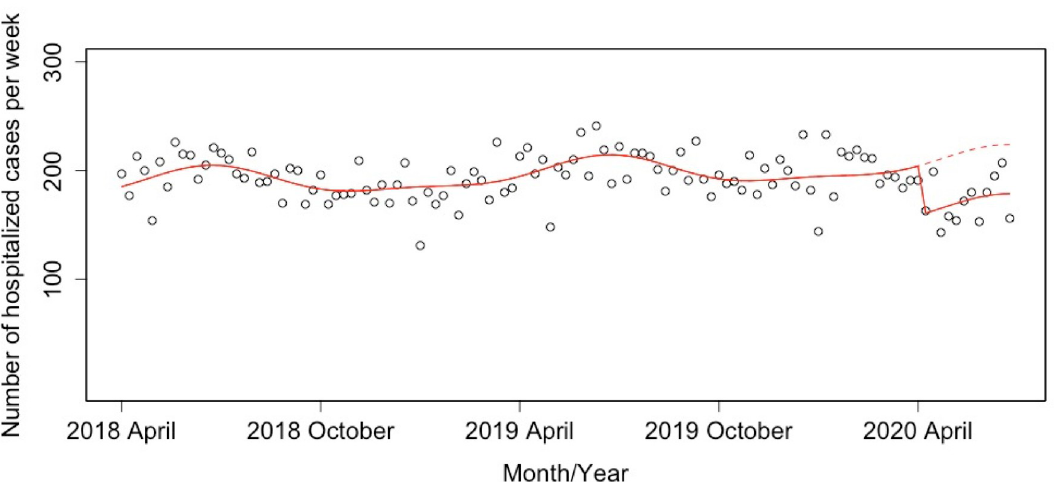
Fig 2. Result of the interrupted time series analysis for the weekly number of independent group inpatients with ischemic stroke between April 1 2018 and June 27 2020. Solid lines indicate the predicted trend based on a model, and dashed lines indicate the predicted trend based on a model in the scenario without the state of